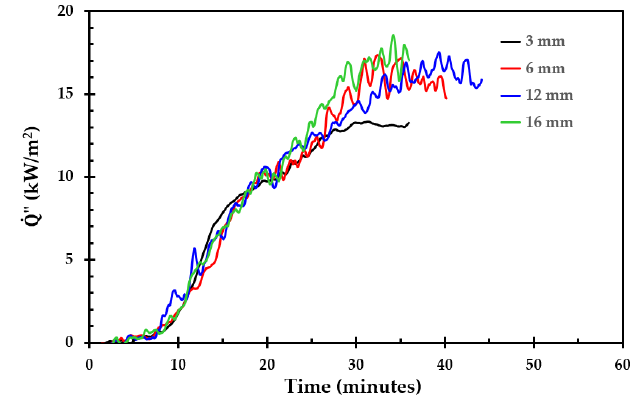
Figure 10. Total heat flux to the steel plates as a function of time. The steel plate thickness is indicated in the figure label.